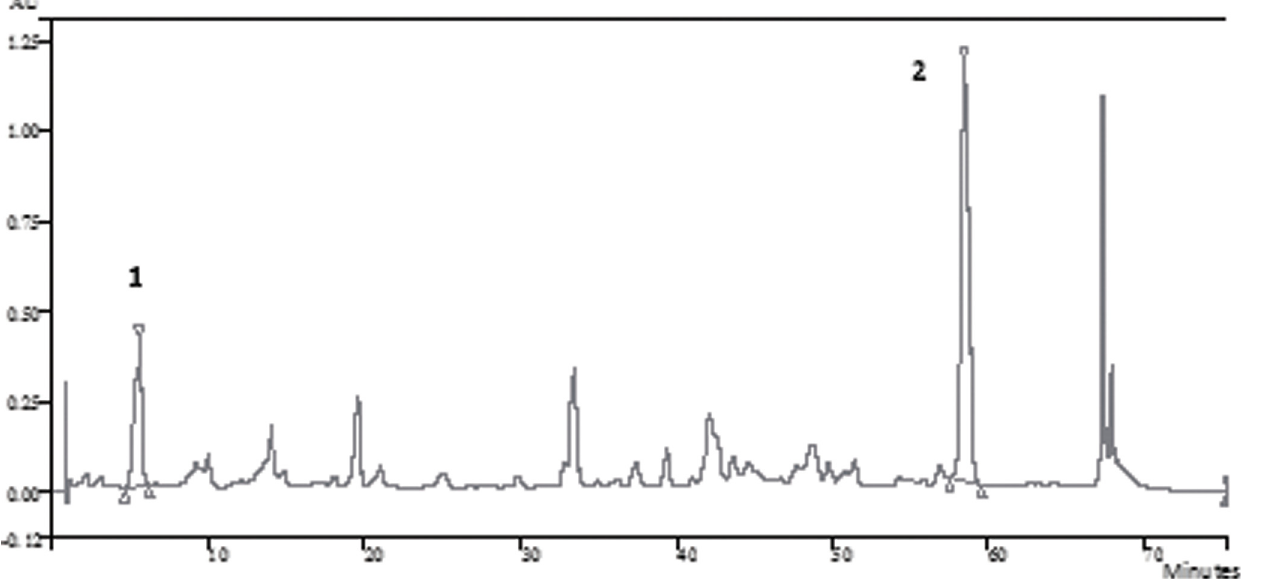
Values showing the same letter, in the same column, do not show signi fi cant differences (p > 0.05) by the Tukey test at 95% con fi dence interval; EtOH – Extracts obtained by ethanolic extraction; SCO 2 – Extracts obtained by SFE (CO 2 as supercritical fl uid); ----Not identi fi